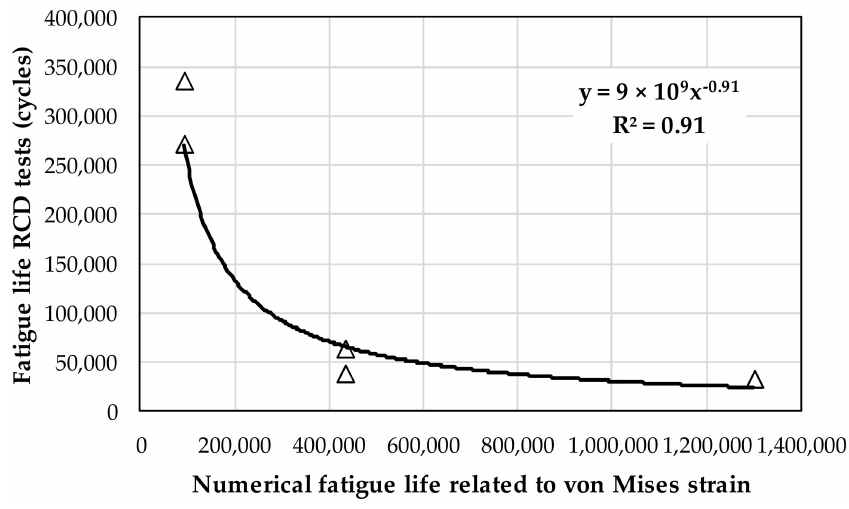
Figure 14. Example of correlation between RCD tests and numerical